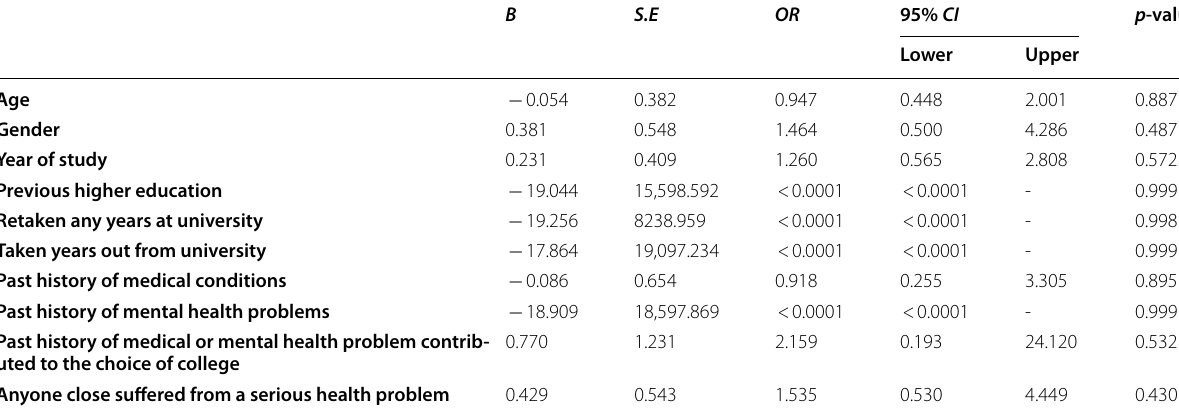
B Regression coefficient, SE Standard error of the coefficient, OR Odds ratio, 95% CI , 95% confidence interval for the odds